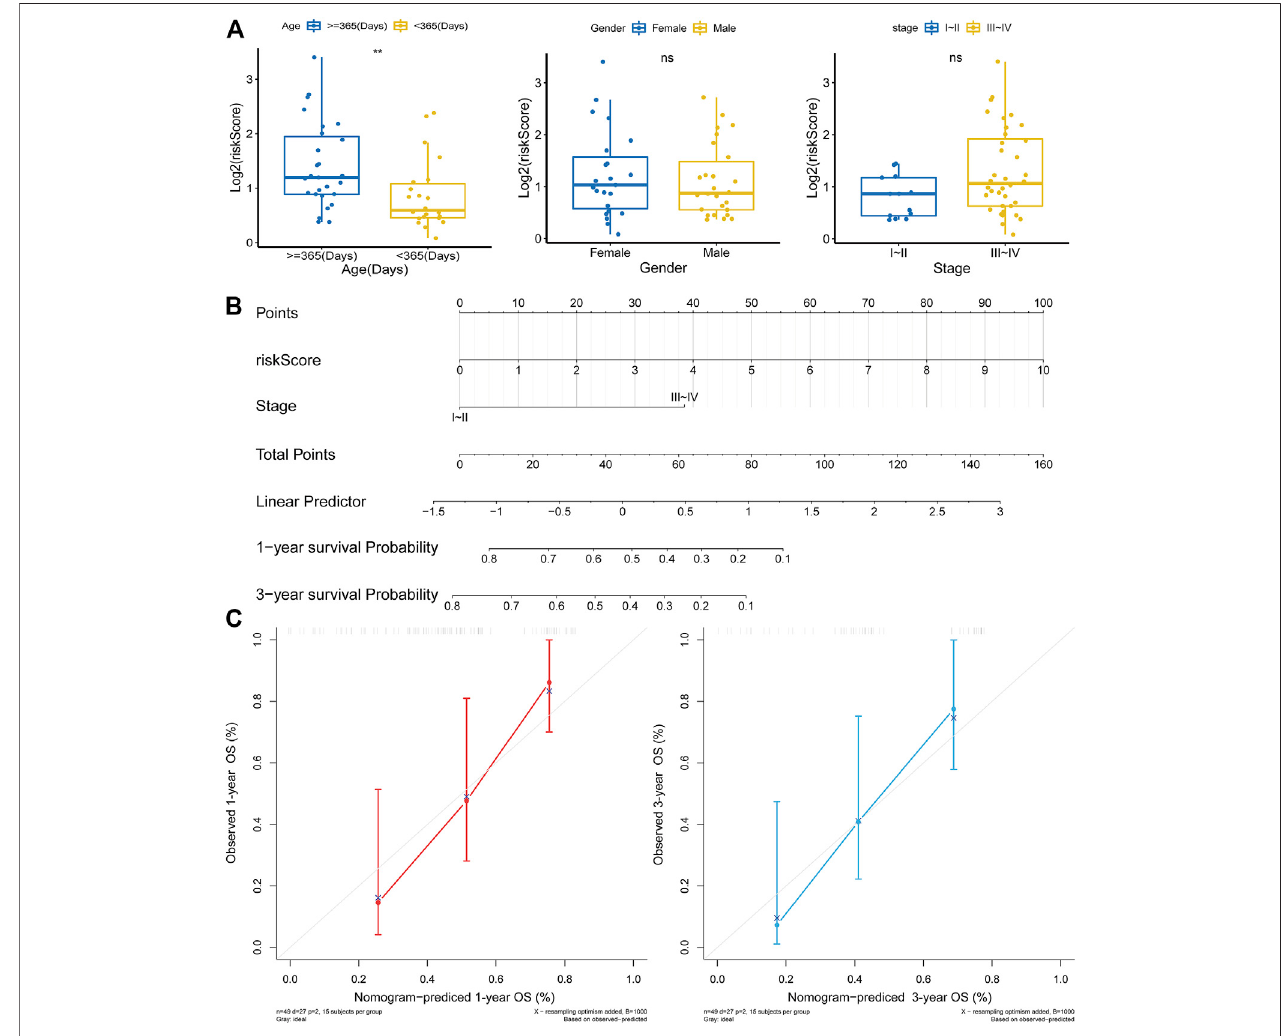
FIGURE 3 | Independent prognostic analysis in MRTK. (A) Correlation analysis between risk score and clinicopathological characteristics. (B) Nomogram that integrated the risk score and stage predicted the probability ofthe 1- and 3-year OS. To calculatethe survival probability, identi fi cation of the patient values on each axis and then foraverticallineupward tothepointaxis wasdrawnforeach value. Thepointsforall variableswereadded,and thissumon thetotalpoint linewaslocated. (C) Calibration plot of the nomogram for predicting probabilities of 1-year and 3-year OS of patients.